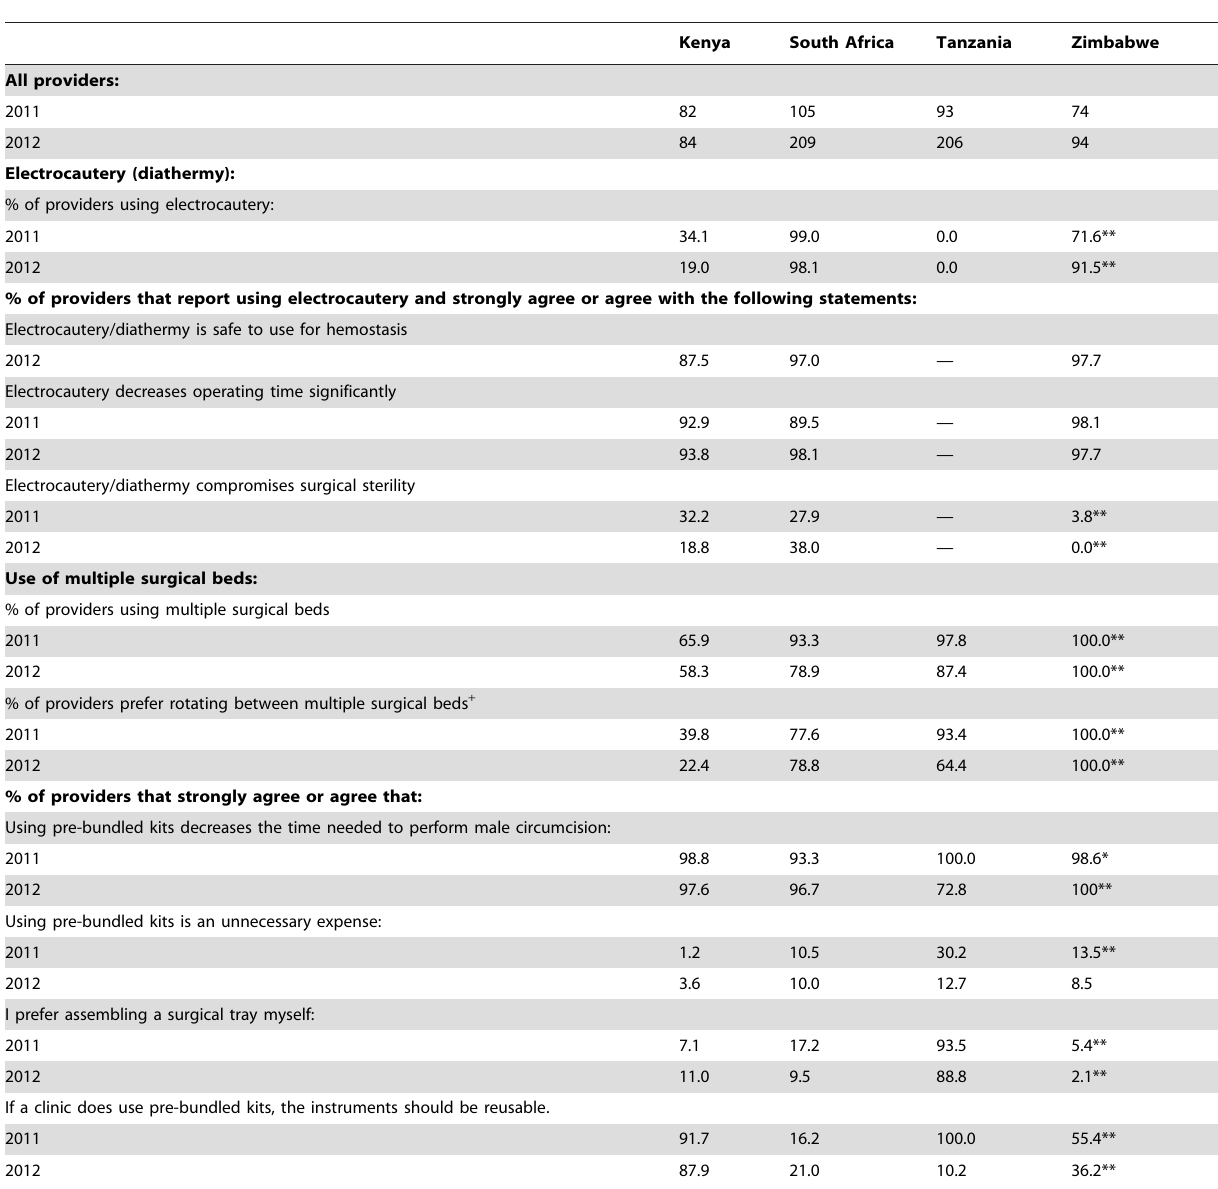
Table 5. Attitudes toward multiple surgical beds, electrocautery and pre-bundled kits, by country/and year.